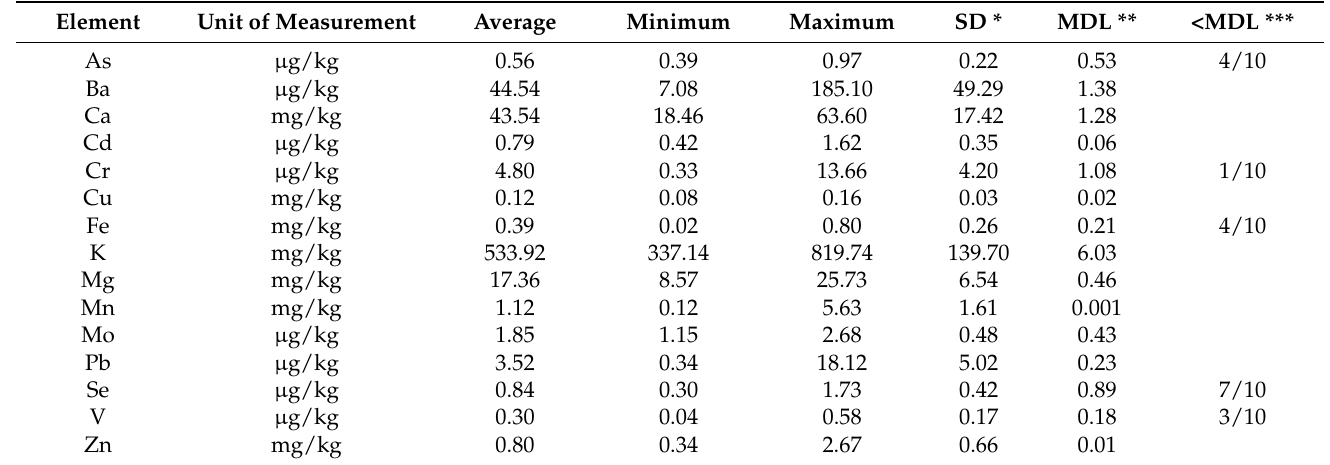
Table 3. Mineral element content of Himalayan balsam honey.